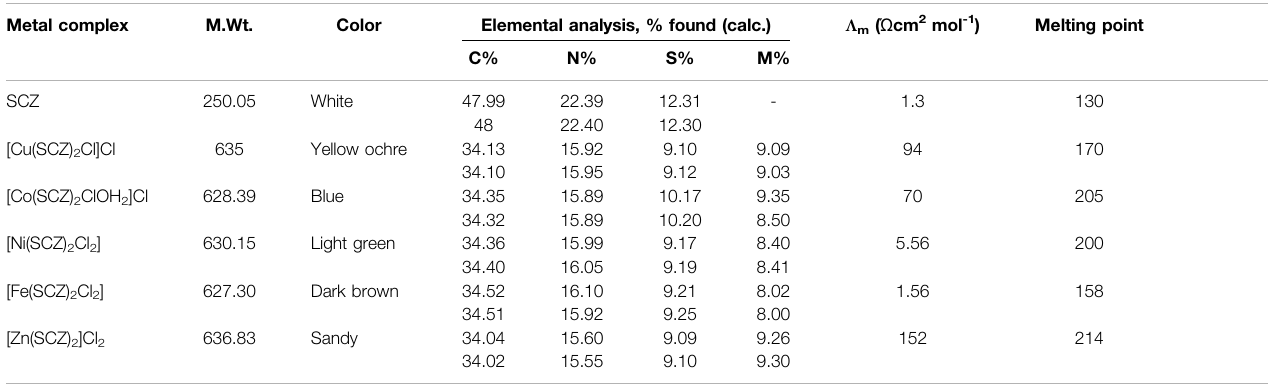
TABLE 1 | Analytical and physical data of SCZ and metal complexes. Metal complex